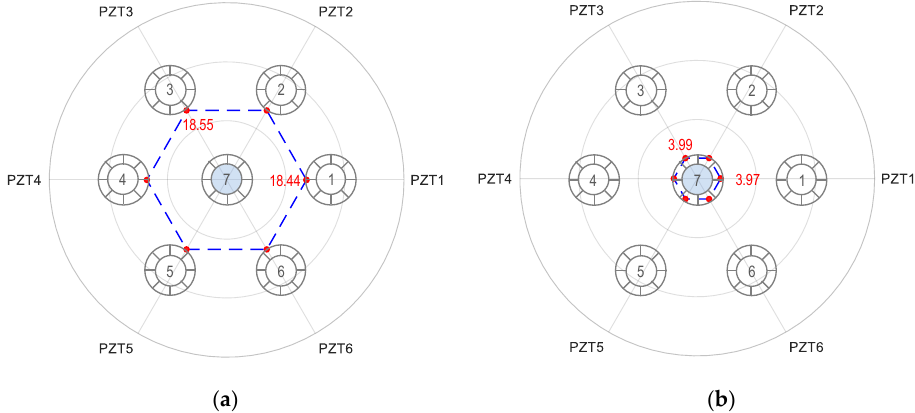
Figure 14. Linear tomography of RMSD indices (%) using all PZTs 1 – 6: Strand 1 breakage. ( a ) Peak 1’s impedance and ( b ) Peak 2’s impedance.